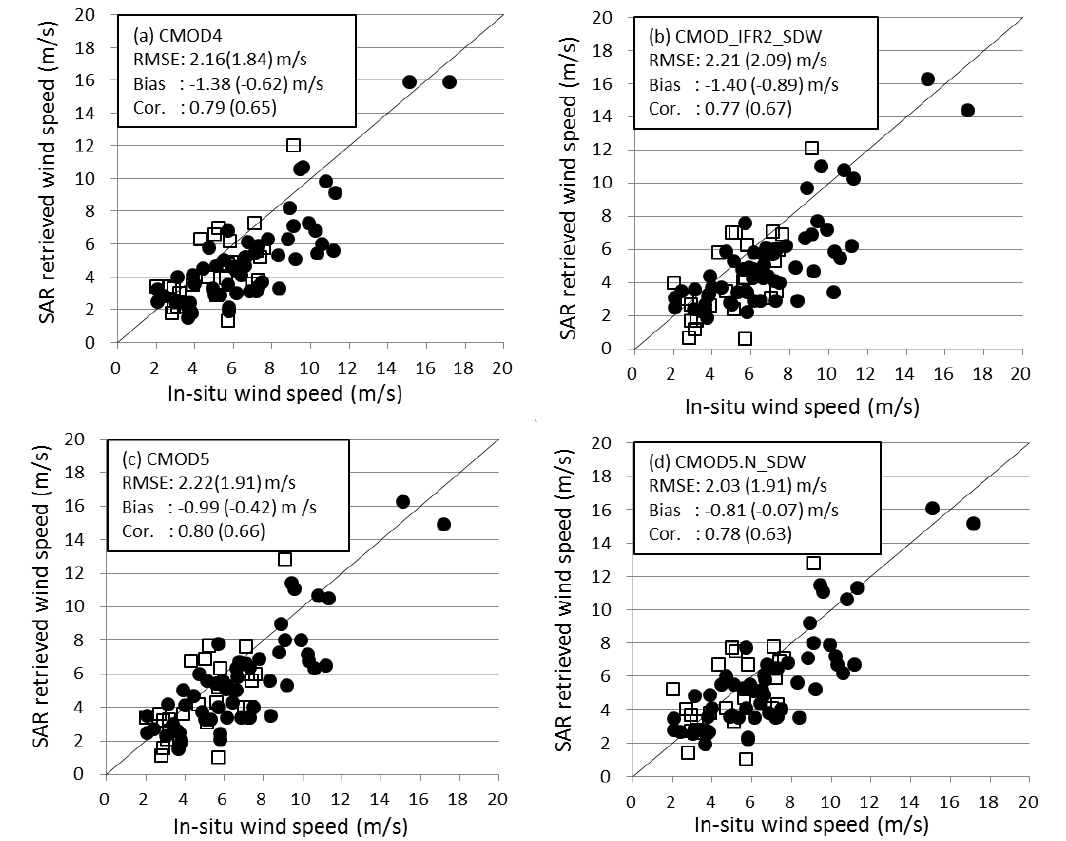
Figure 6. Same as Figure 3, but for 84 offshore winds by IMP (daub circle) and WSM (square) at both Hiratsuka and Shirahama. The statistics are for 84 cases, and those for WSM (26 cases) are in parentheses.